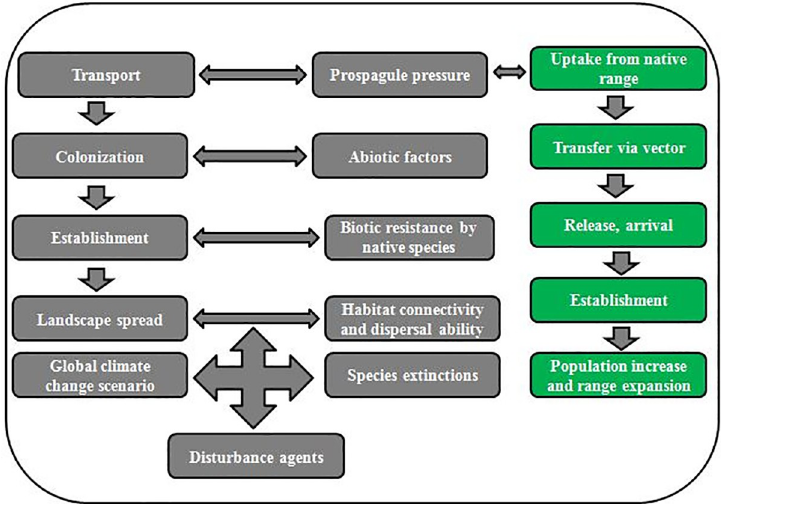
Fig 1. Main stages and factors affecting invasion success of introduced plants [20,